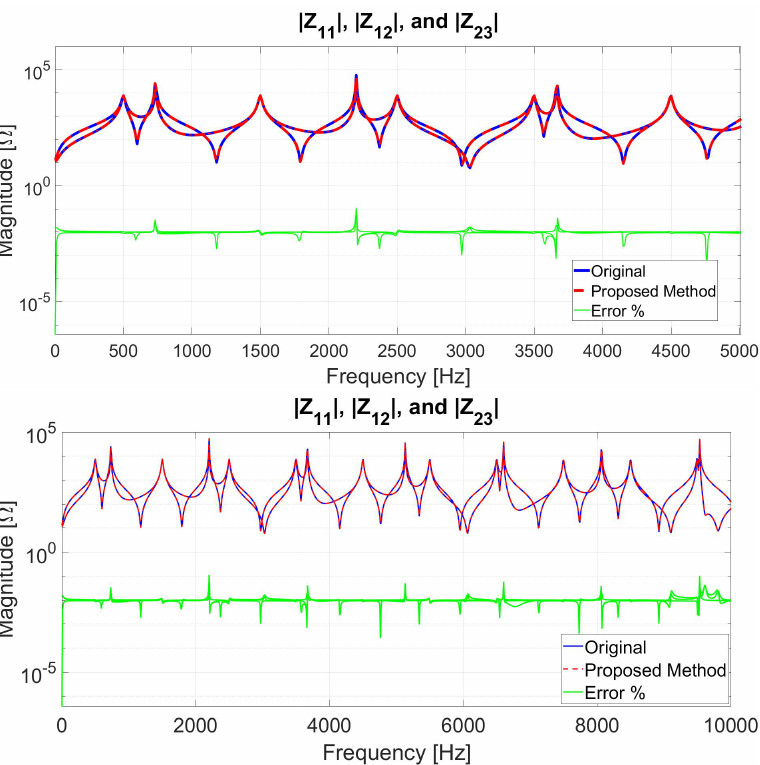
Figure 17. The magnitude of the measured and fitted impedance using the proposed model, | Z 11 | , | Z | , and | Z | . 23 12